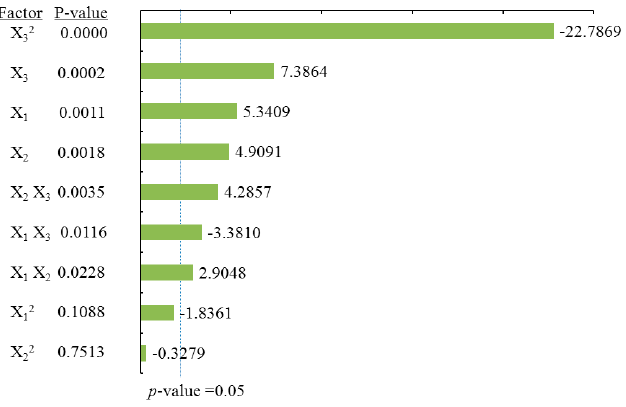
Figure 4. Pareto chart of the effects for the dihydromyricetin yield. Standardized effect estimate (absolute value).